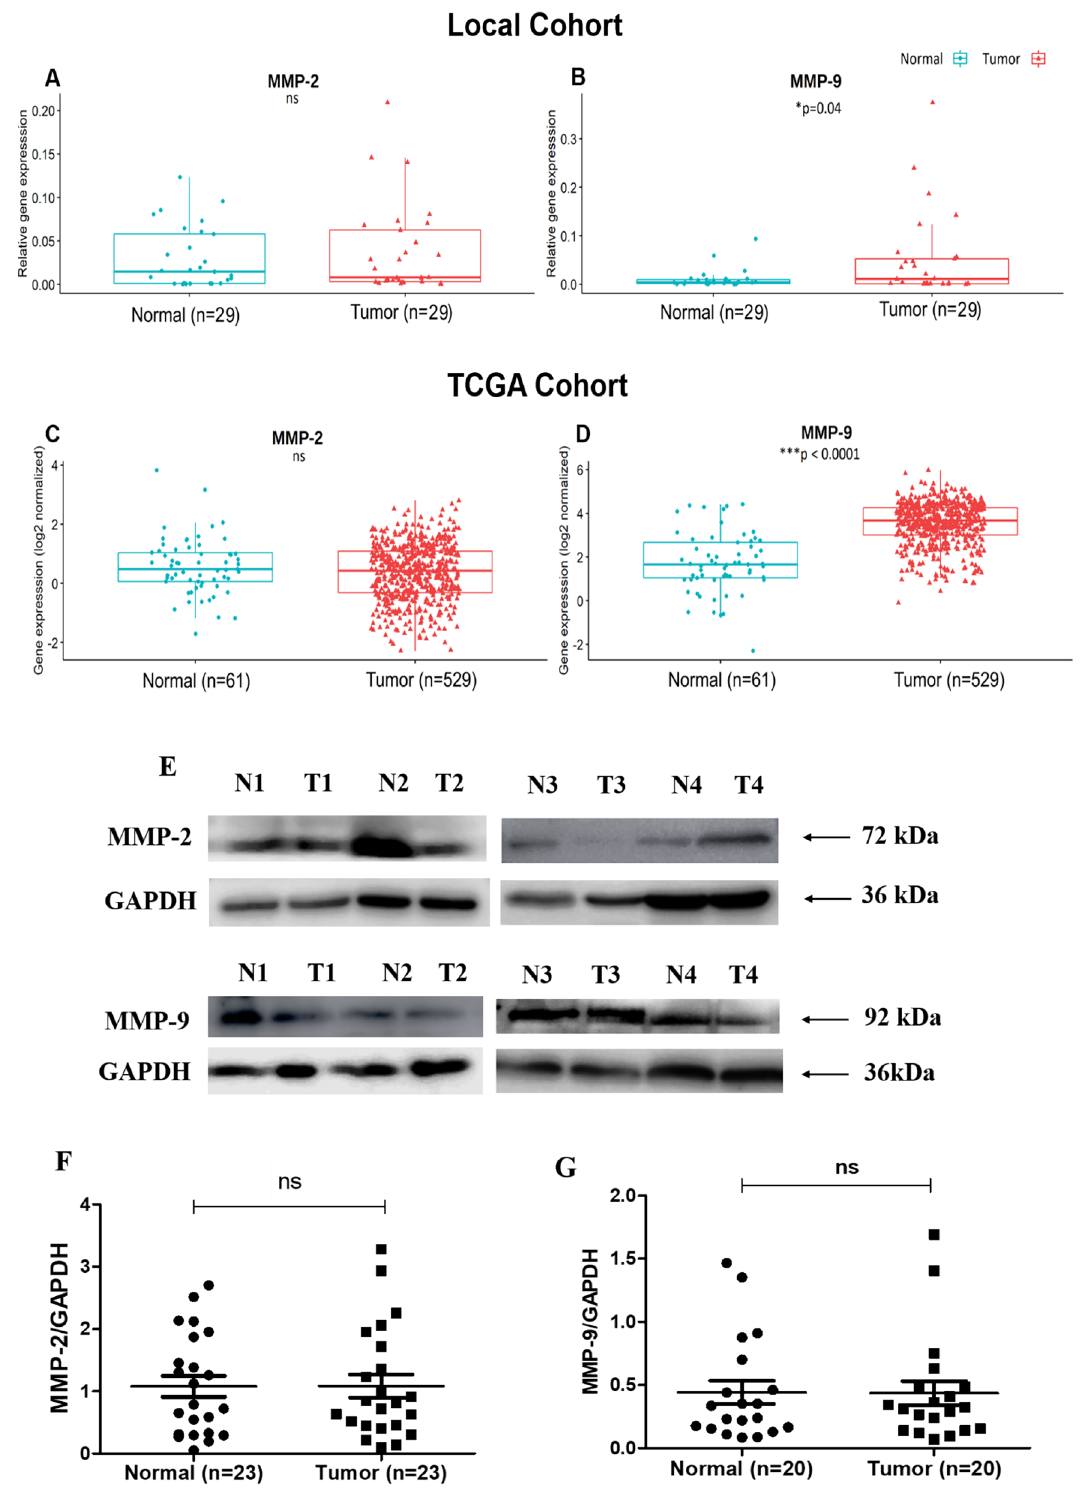
Figure 7. ( A – D ) Gene expression of metastasis markers in breast cancer patients ( A ) MMP-2 , ( B ) MMP-9 in local cohort ( C ) MMP-2 , ( D ) MMP-9 in TCGA cohort and ( E – G ) Protein expression of metastasis markers ( E ) Representative blots in adjacent normal (N) and tumor (T) tissues, ( F ) Densitometric analysis of MMP-2 and ( G ) MMP-9 levels in adjacent normal and tumor